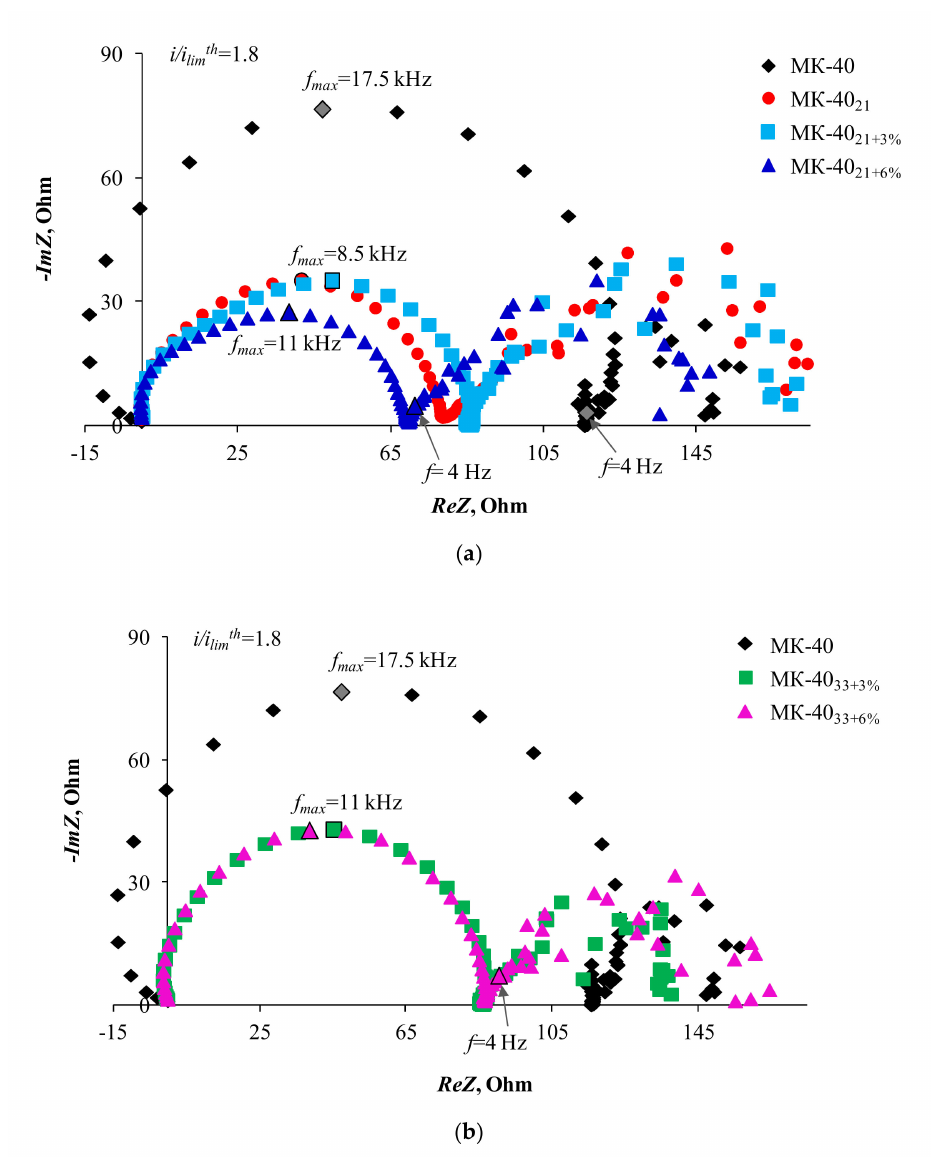
Figure 8. Electrochemical impedance spectra of the MK-40 as well as MK-40 21 , MK-40 21 + 3% , MK-40 21 + 6% ( a ) and MK-40 33 + 3% , MK-40 33 + 6% ( b ) samples at i / i th